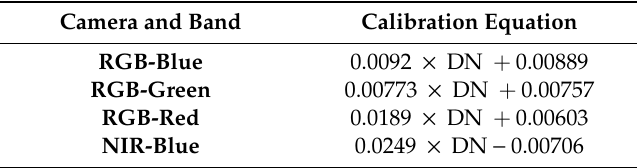
Table 5. Calibration equations for each of the four camera bands. Equations were derived from comparison of camera and Tec5 measurements of five reference targets.